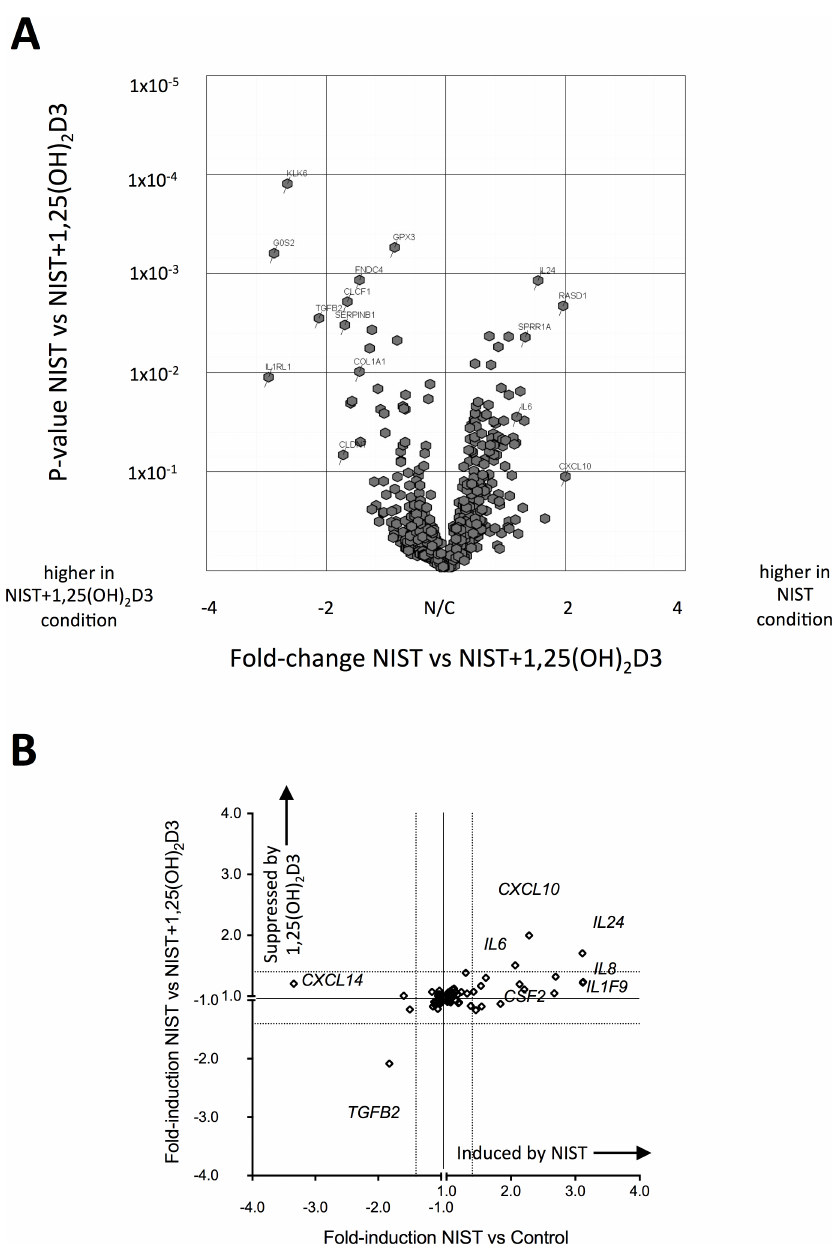
Fig 1. Transcription microarray of 24 hour primary human bronchial epithelial cell (HBEC) cultures stimulated with NIST in the presence/absence of vitamin D. (A) Volcano plot of the 510 genes with (cid:21) 1.4 fold differential expression comparing 50μg/ml NIST stimulated to unstimulated 24 hour cultures (n = 4), showing fold-change in gene expression in NIST stimulated cultures in the presence vs absence of 100nM 1,25(OH) 2 D3 (horizontal axis) plotted again probability of statistical significance for that fold-change (vertical axis). (B) Plot showing microarray results for fold-change in expression of all cytokine genes upon stimulation of HBECs with 50μg/ml NIST (horizontal axis) and fold-change in gene expression upon addition of 100nM 1,25(OH) 2 D3 to NIST-stimulated cultures (vertical axis).